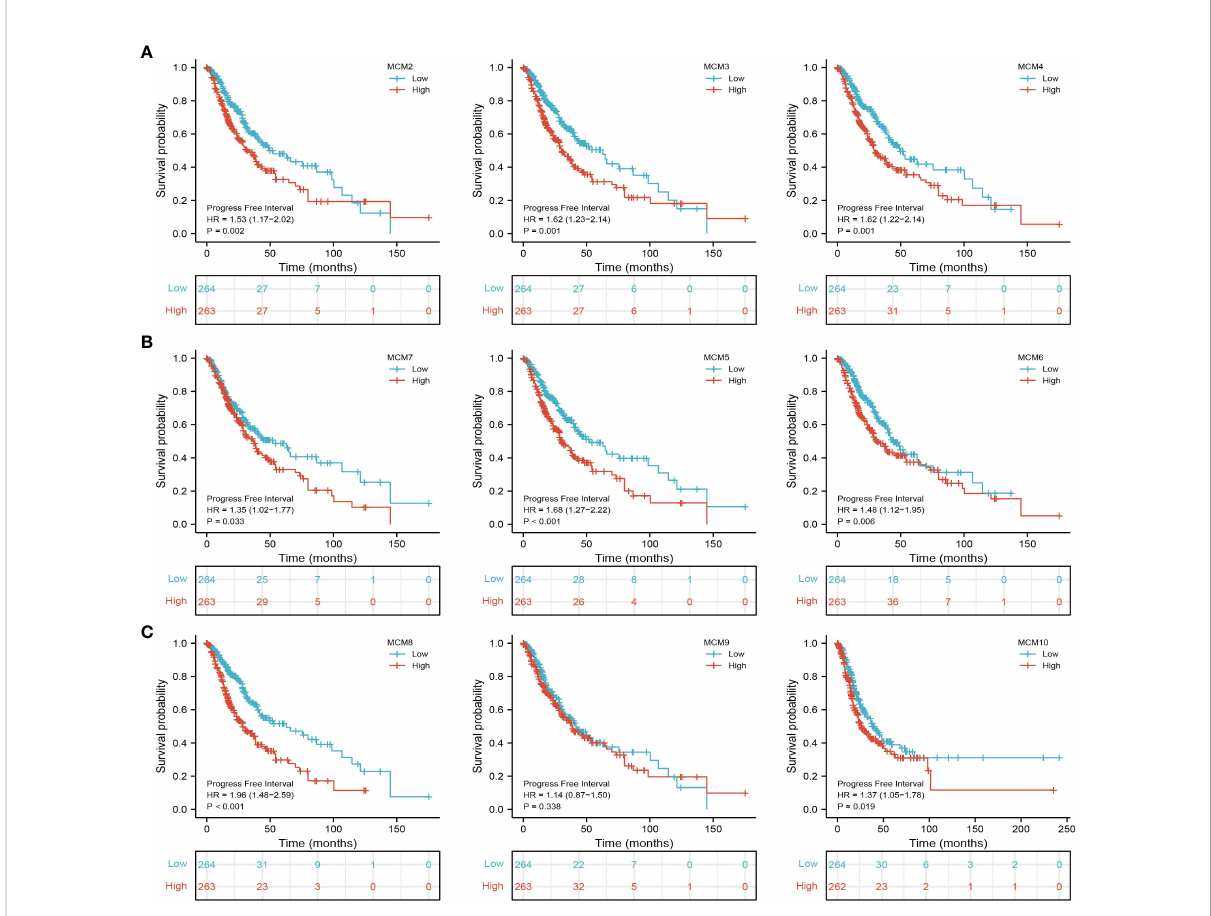
FIGURE 5 The progression-free survival (PFS) of MCMs in glioma. (A – C) The progression-free survival of MCMs in glioma was examined by the TCGA